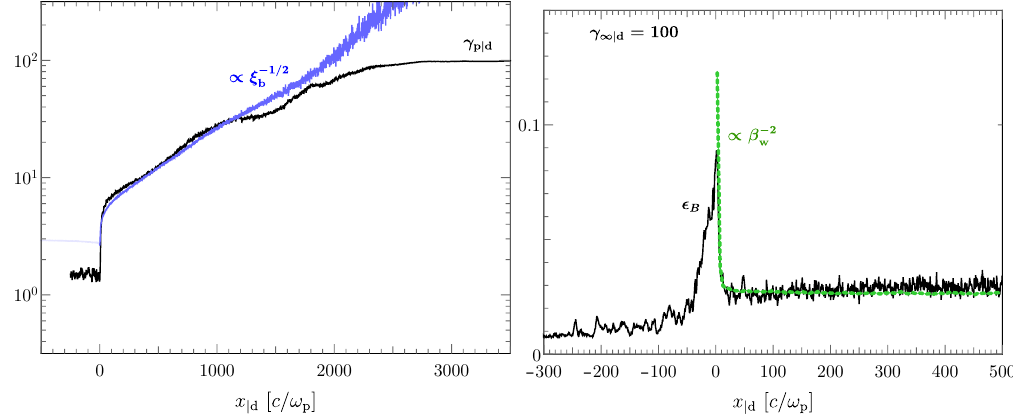
Figure 5. Left panel: Lorentz factor of the background plasma (black curve) from a PIC simulation with γ sh = 173 (i.e., γ u | d = 100) and σ = 0. The blue curve plots the theoretical scaling, Equation (12). Right panel: Profile of (cid:101) B around the shock front (black curve), compared with the magnetic compression law, (cid:101) B ∝ β − 2 (green curve). From w | s